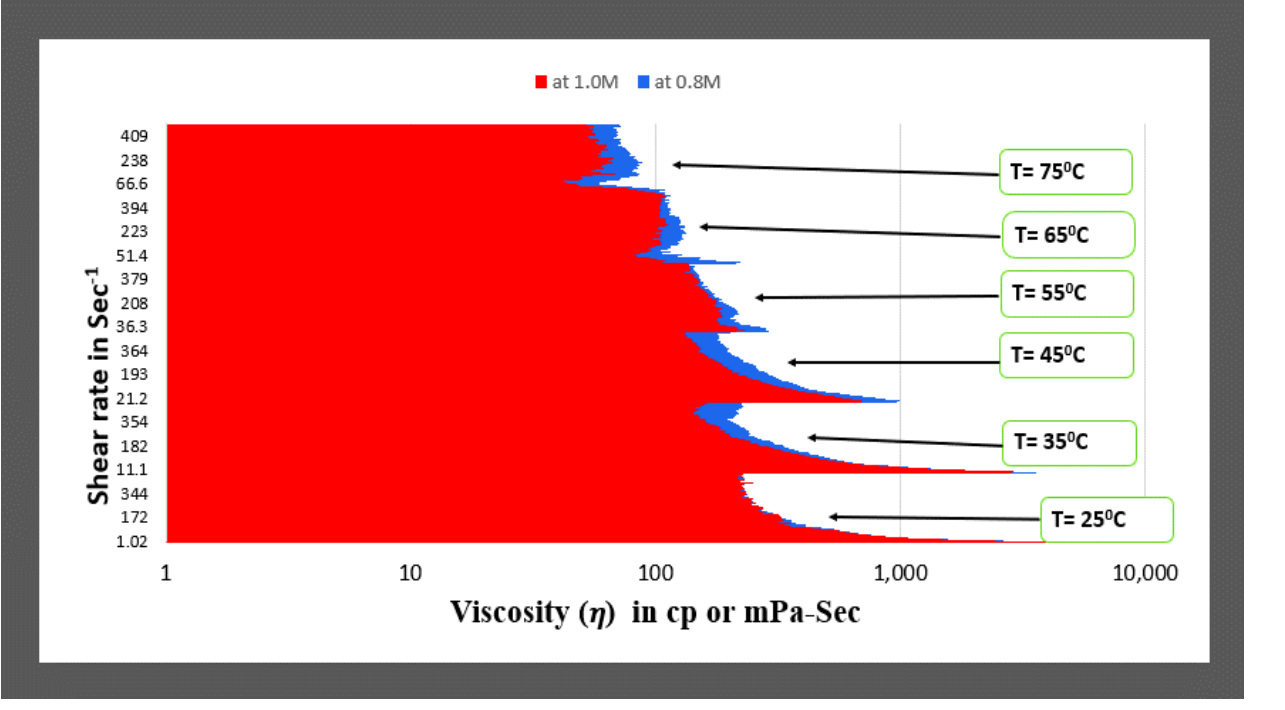
Table 1. Regression functions for viscosity change with a varying shear rate of different viscoelas- tic type1 fluids at Temperature 25 °C.